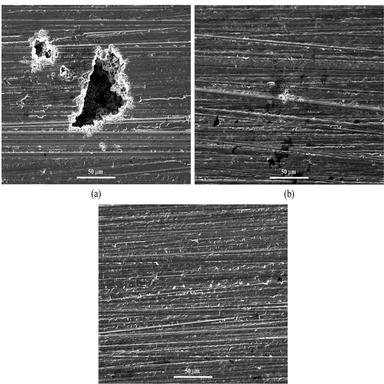
Surface morphologies observed by scanning electron microscope of: (a) Al-based, (b) Al-25AlN, and (c) Al-25AlN-4Mg alloy specimens after −660 mVSCE application for 1 h in 0.1 M NaCl solution.